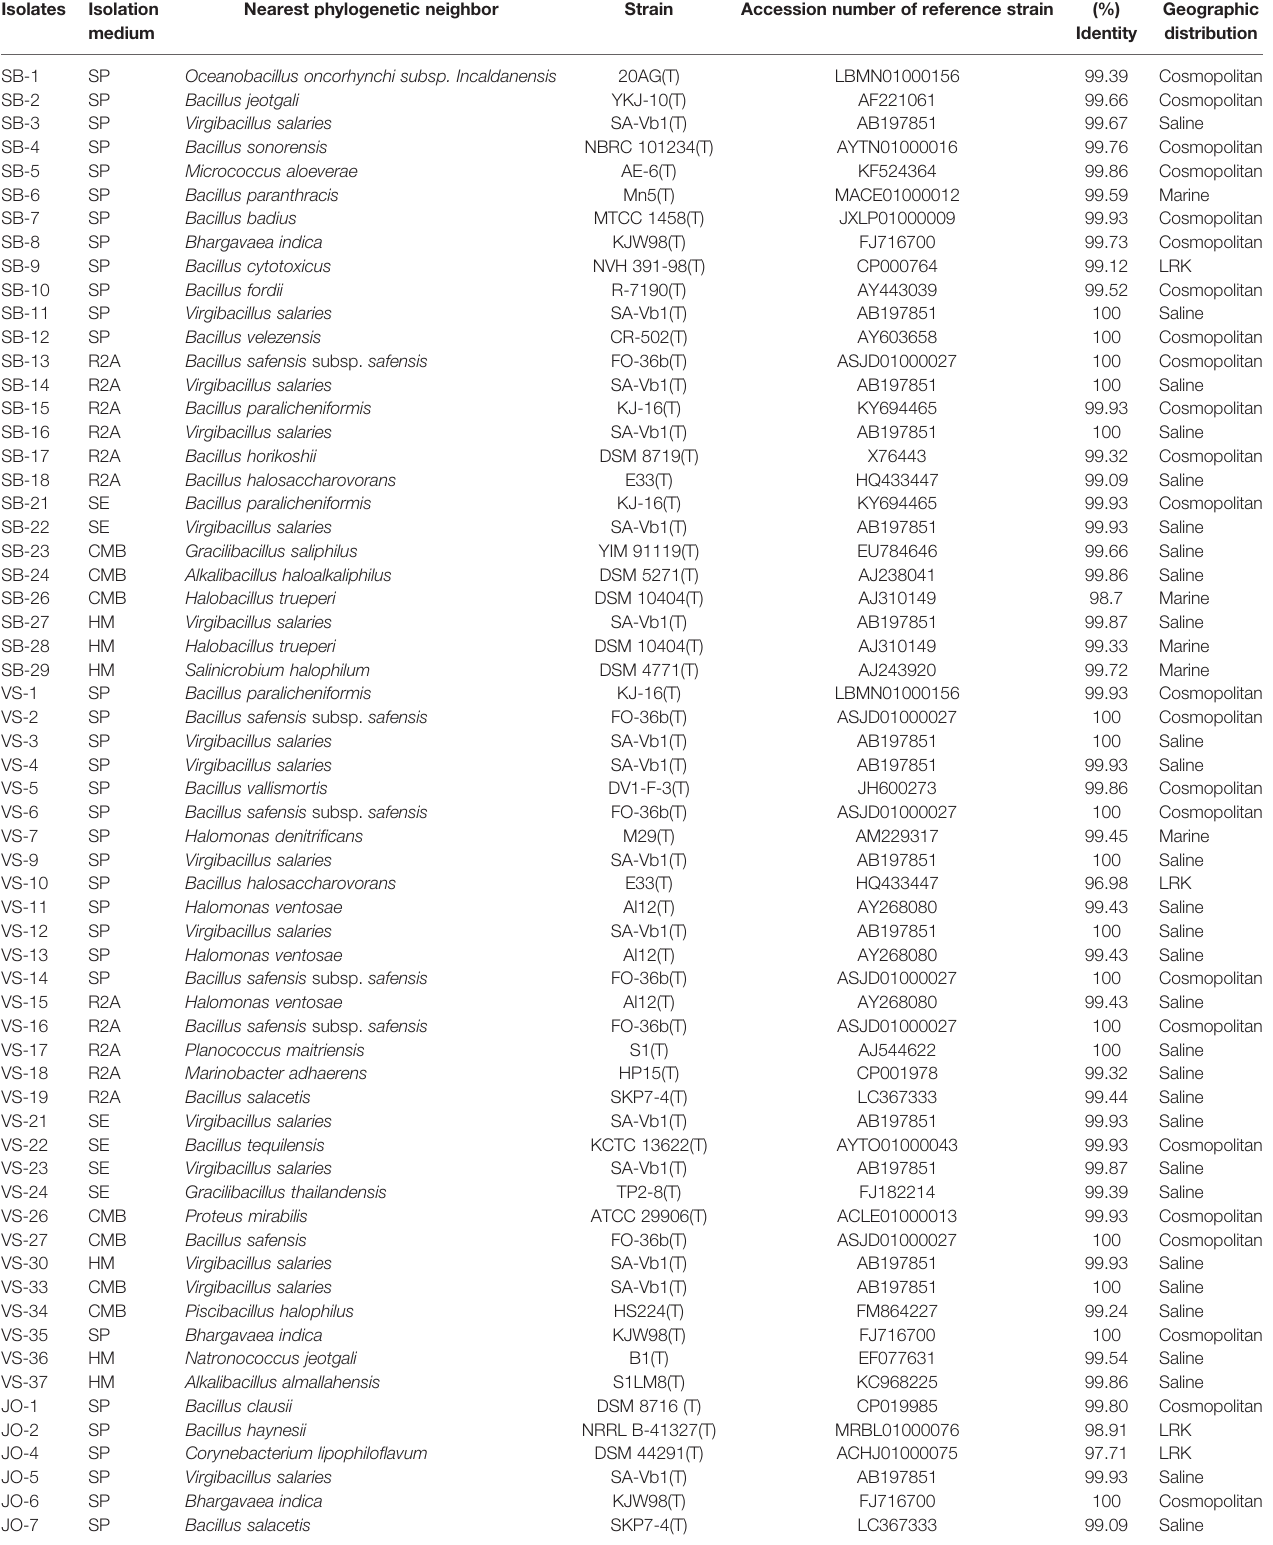
TABLE 3 | Overall pro fi le of isolates obtained from Little Rann of